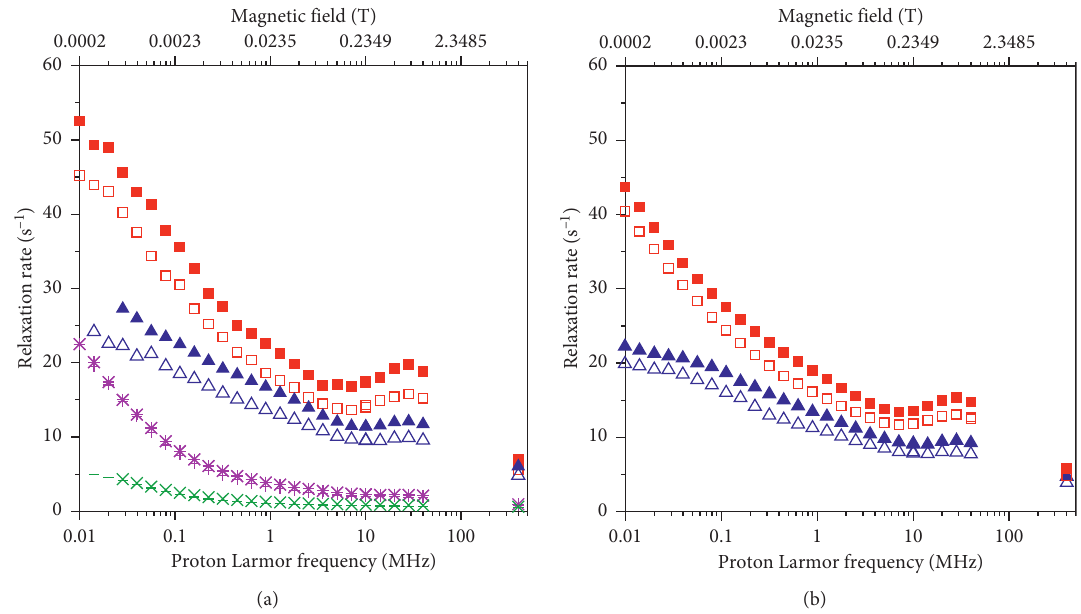
Figure 5: (a) Experimental 1 H R1 profiles of pineapple juice with alginate (red squares: 15%, and blue triangles: 5% w/w) at 25 ° C (solid symbols) and 37 ° C (empty symbols), and of alginate solutions (pink symbols: 15%, and green symbols: 5% w/w; ∗ and × : 25 ° C, + and -: 37 ° C). (b). Experimental 1H R1 profiles of the Mn 2+ solutions with alginate (red squares: 15%, and blue triangles: 5% w/w) at 25 ° C (solid symbols) and 37 ° C (empty symbols).